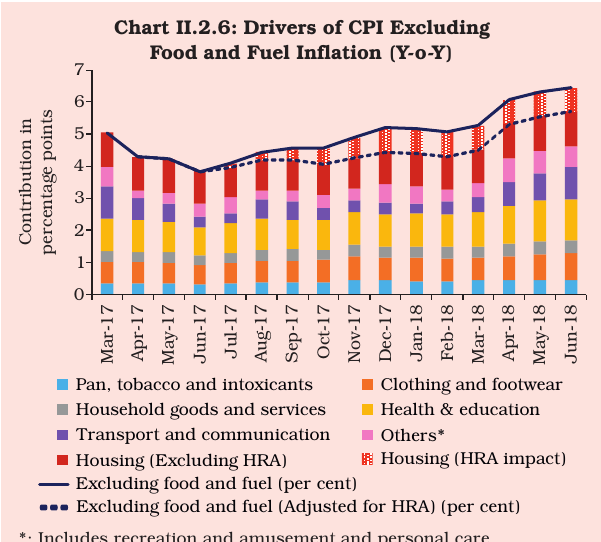
Chart II.2.6: Drivers of CPI Excluding Food and Fuel Inflation (Y-o-Y)